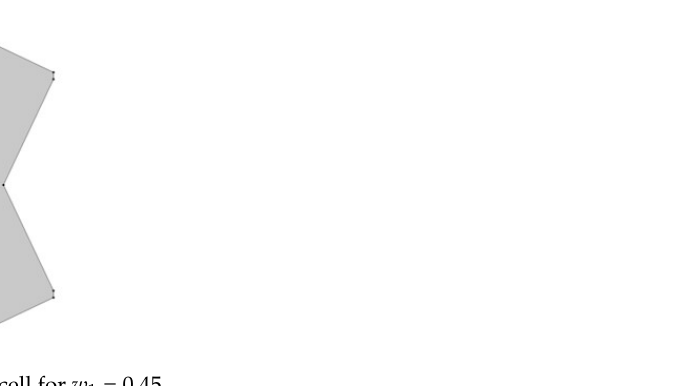
Figure 6. The obtained unit cell for w 1 = 0.15.